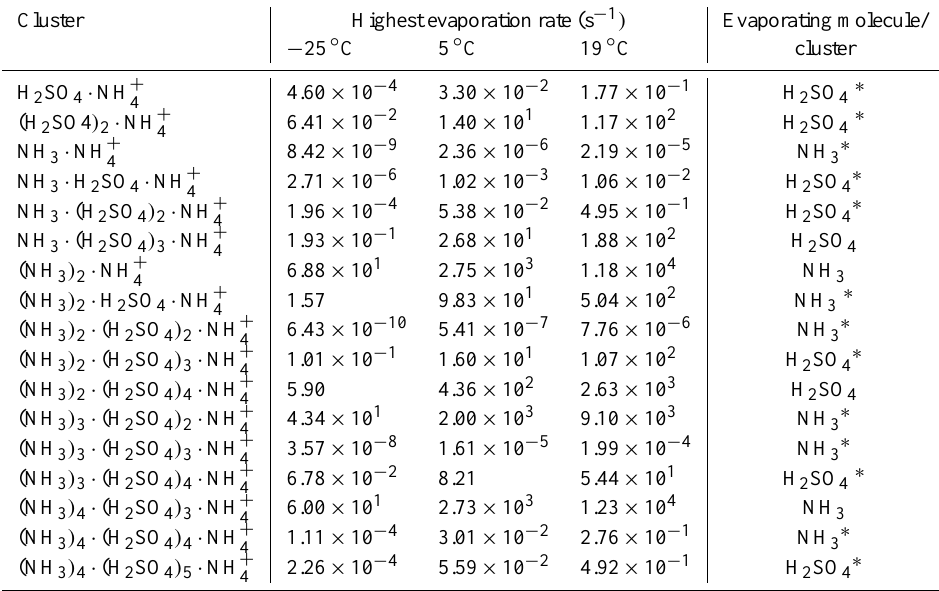
Table 2. Evaporation rates from cation clusters, used for the ACDC model simulations. Clusters that were seen in the APi-TOF spectra are shown with the ∗